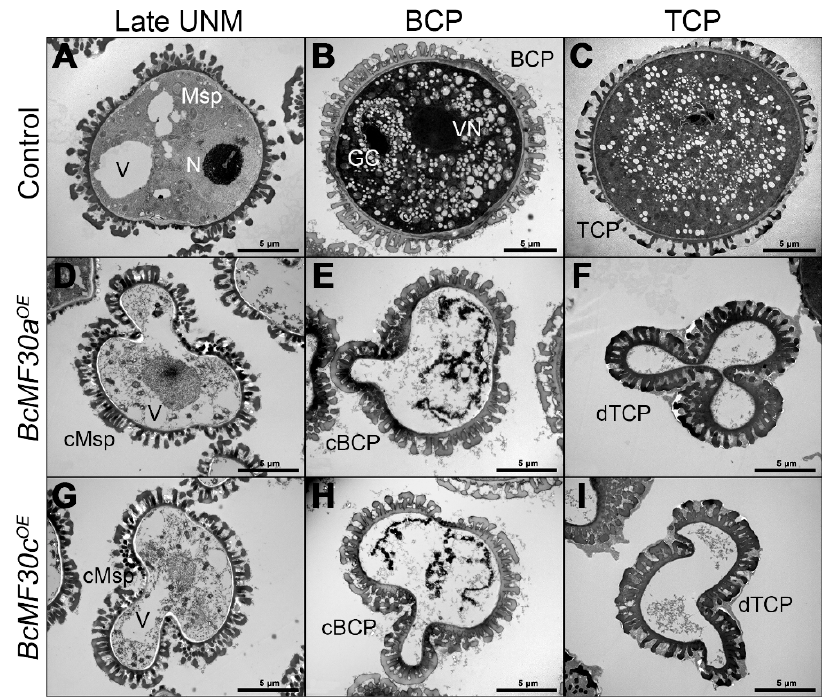
Figure 5. Transmission electron microscopy (TEM) observation of pollen grains from BcMF30a OE and BcMF30c OE plants of Brassica campestris . Ultrastructure of pollen grains at different developmental stages from the control ( A – C ), BcMF30a OE ( D – F ), and BcMF30c OE ( G – I ) plants. ( A , D , G ), late uninucleate stage; ( B , E , H ), bicellular stage; ( C , F , I ), tricellular stage. BCP, bicellular pollen; cBCP, collapsed BCP; GC, generative cell; Msp, microspore; cMsp, collapsed Msp; N, nucleus; TCP, tricellular pollen; dTCP, degenerated TCP; V, Vacule; VN, vegetative nucleus. Bars = 5 μ m.